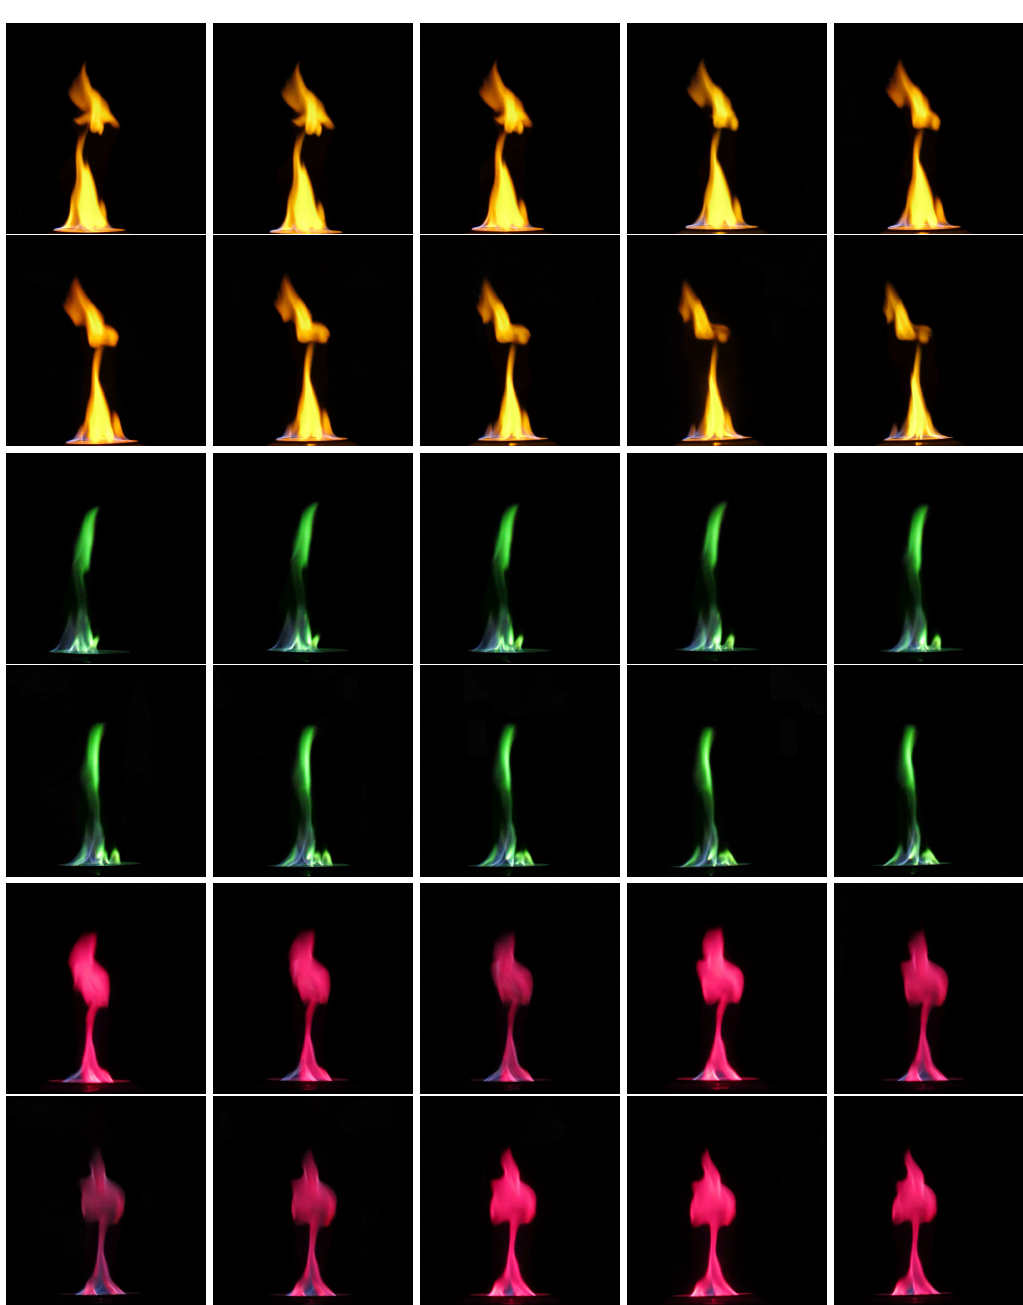
Figure 19. Simultaneously captured flame images from different cameras. Every two rows show the results of one